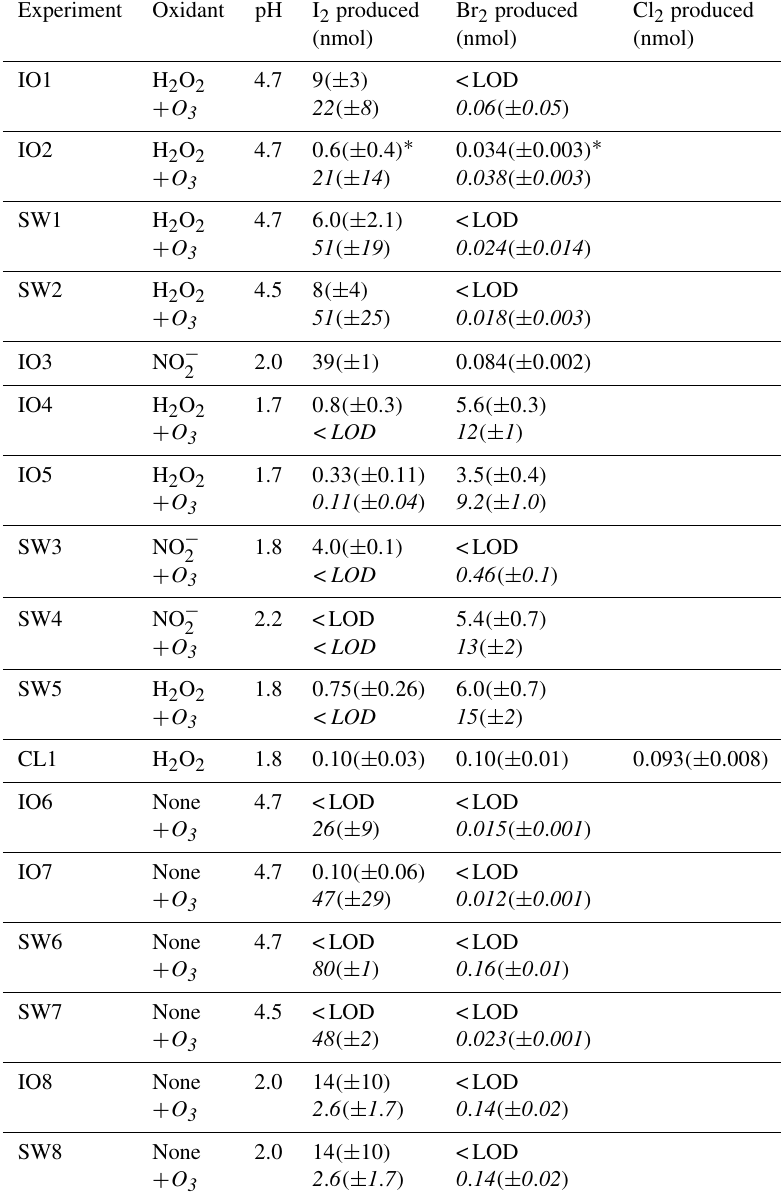
Table 2. Results for all experiments performed. The first line in an experiment represents the integrated totals of molecular halogen production after 1h of irradiation ( t = 0 through t = 1h). The results on italicized lines are 1h integrated production amounts beginning once additional ozone was introduced to the flow tube. Average LODs across experiments were 1 . 8 ± 0 . 4, 1 . 2 ± 0 . 3, and 9 ± 2pmolmol − 1 for Br 2 , Cl 2 , and I 2 respectively. “IO#” represents samples composed of Instant Ocean, and “SW#” represents saltwater samples, composed of reagent salts. “CL1” here represents the experiment performed using 0.56M high-purity